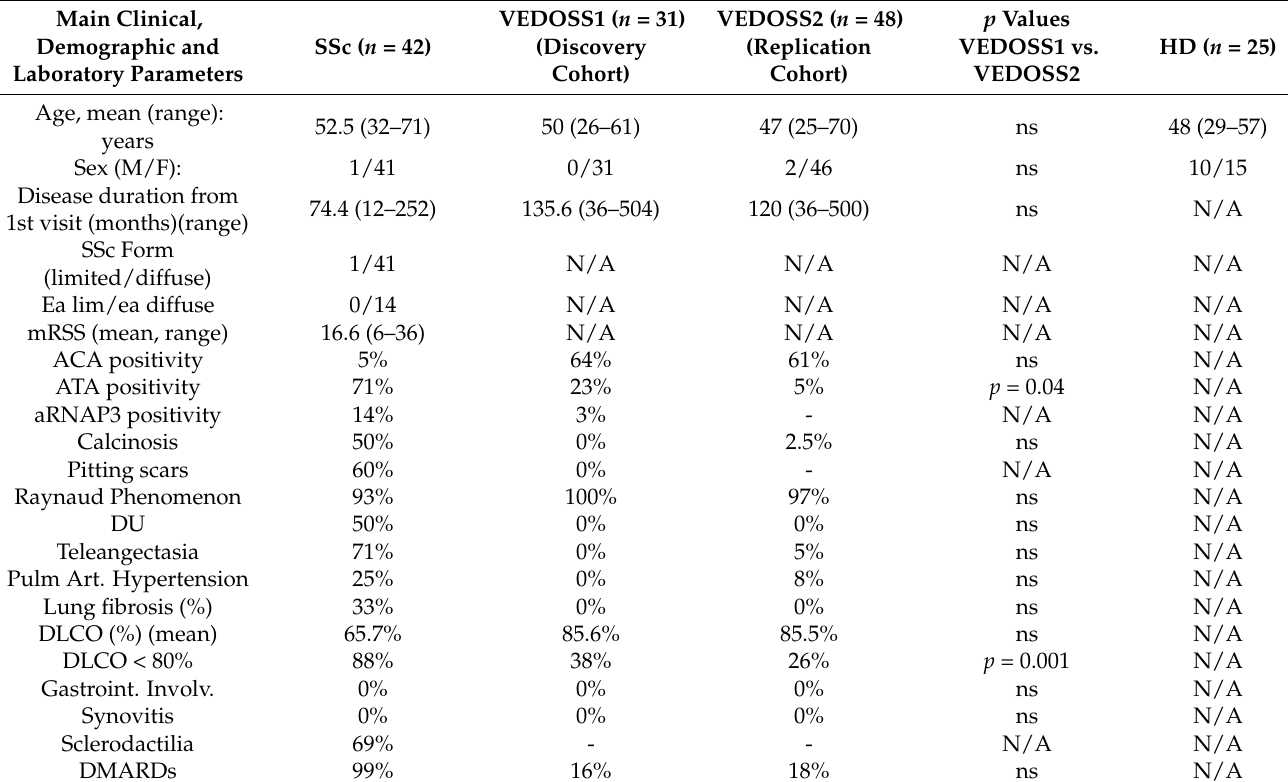
Table 1. Main clinical, Demographic and Laboratory features of SSc, HD and VEDOSS patients at